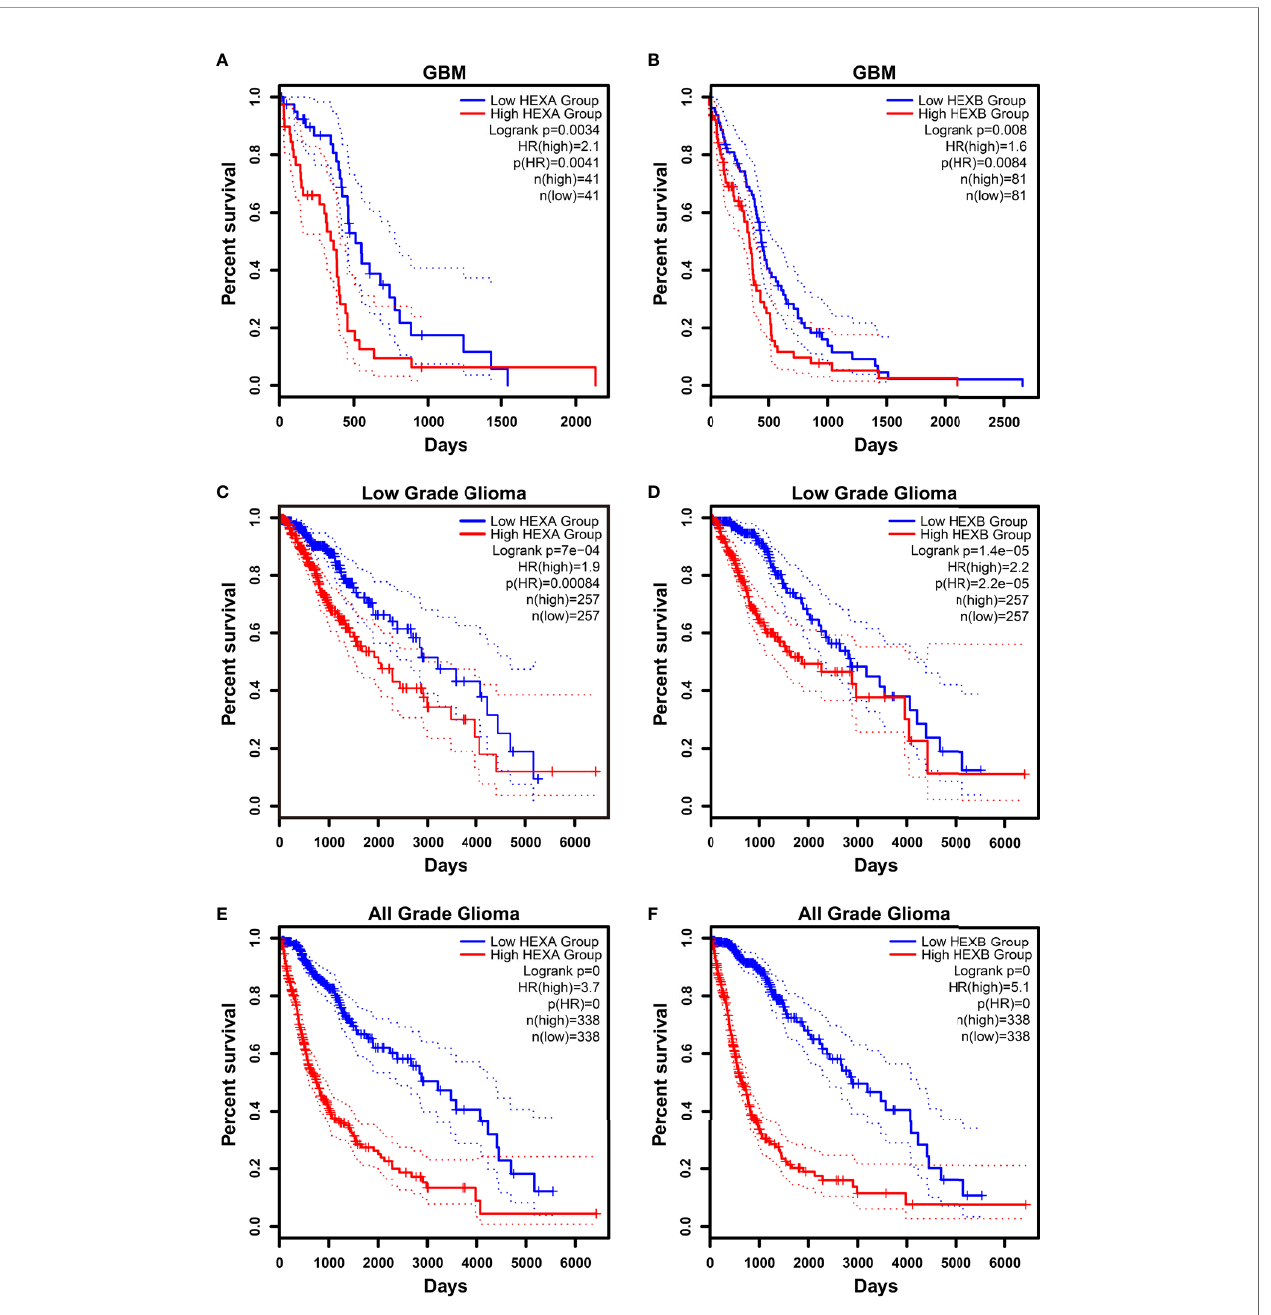
FIGURE 6 | Higher expression of HEXA and HEXB was associated with poor prognosis in GBM patients according to GEPIA2 database. (A, B) Survival analysis of GBM gliomas patients related with HEXA and HEXB expression. (C, D) Survival analysis of low grade glioma patients related with HEXA and HEXB expression. (E, F) Survival analysis of glioma patients of all grades related with HEXA and HEXB expression. (survival analyses, High vs Low), p <0.05 was considered statistically signi fi